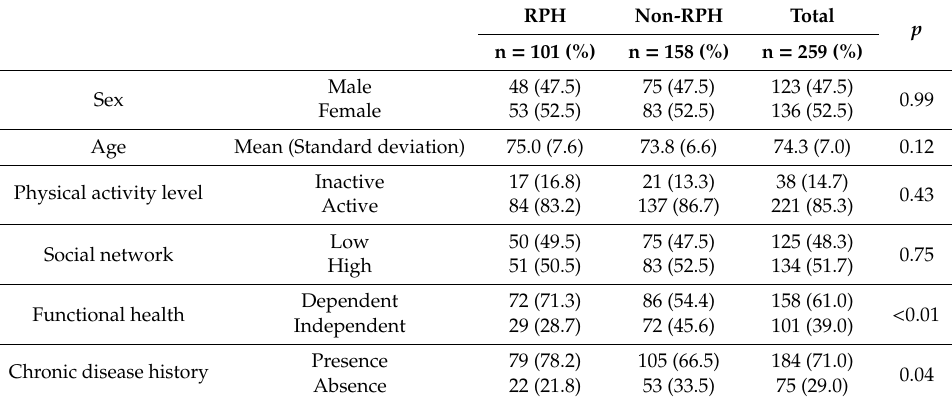
Table 1. The demographic characteristics of the two respondent